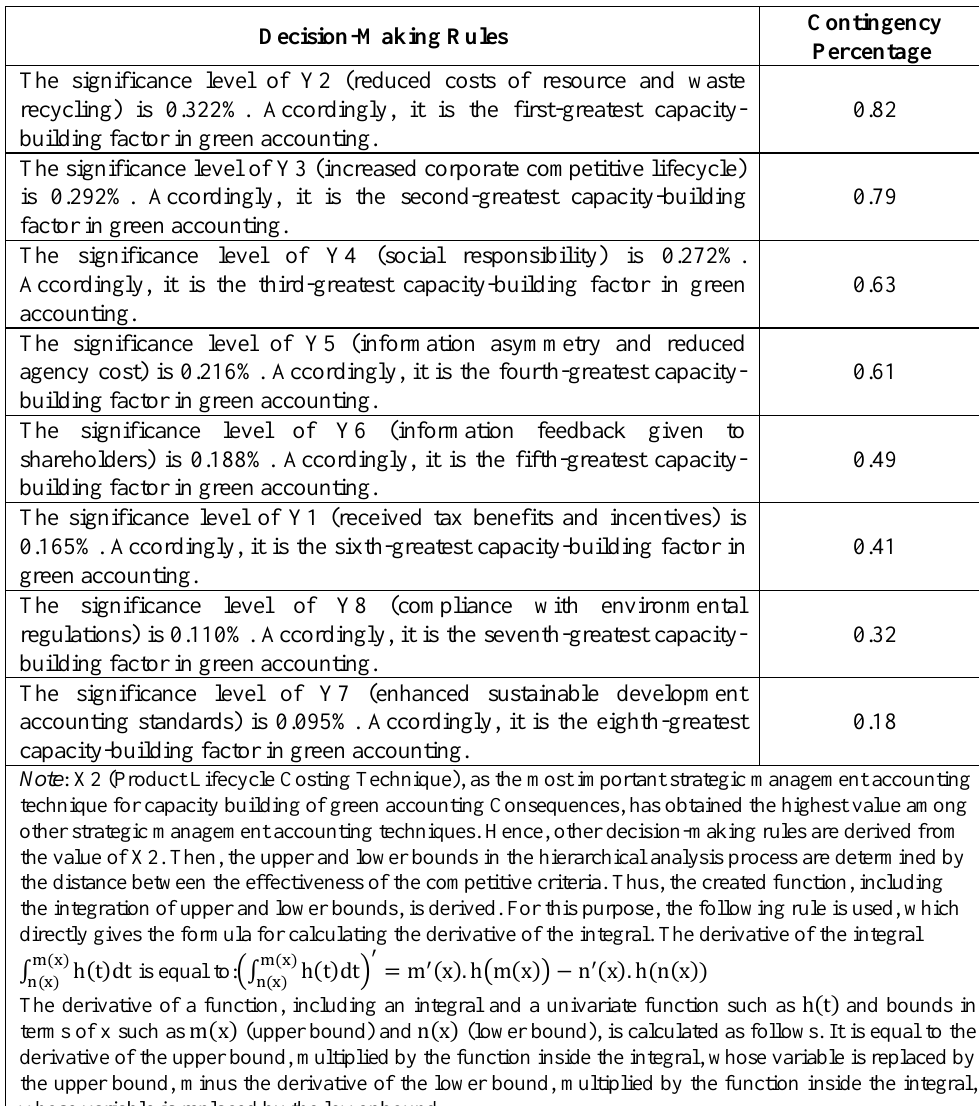
Table 12. X2-derived decision rules in the extended rough set